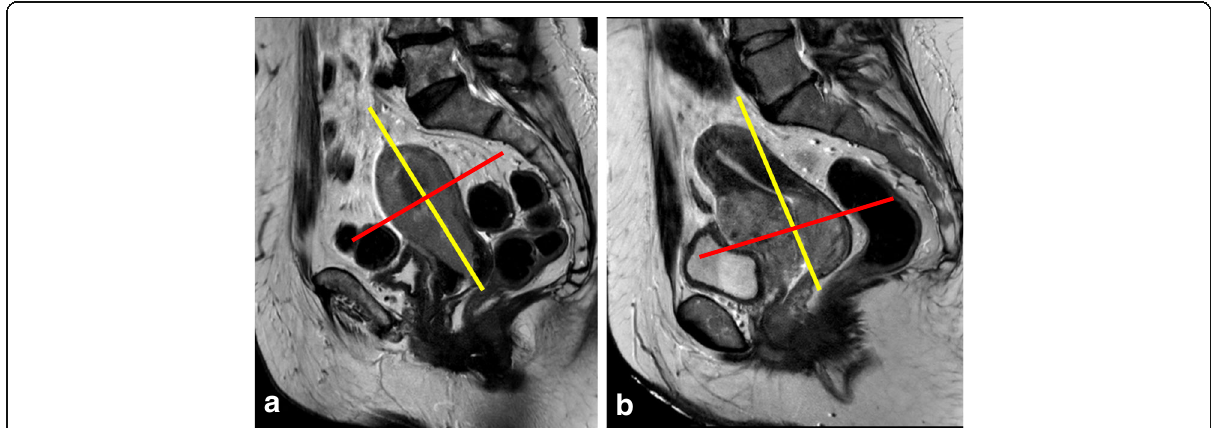
Fig. 2 Planning of MRI sequences in endometrial ( a ) and cervical ( b ) cancers. Yellow line indicates the coronal plane, red line indicates the axial oblique